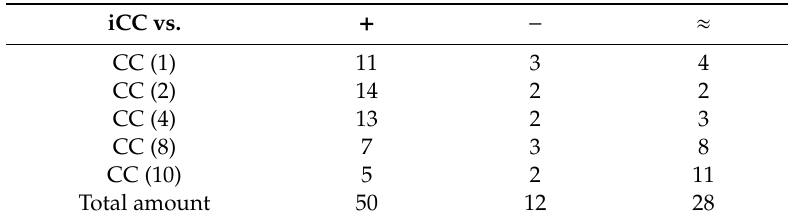
Table 3. Mann–Whitney U test, pop_size is 25.